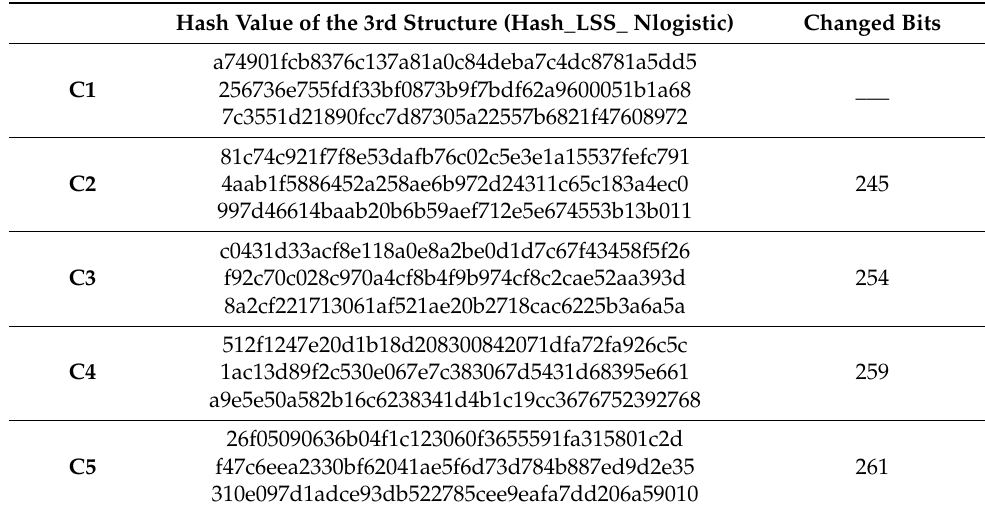
Table 6. Hash values of third